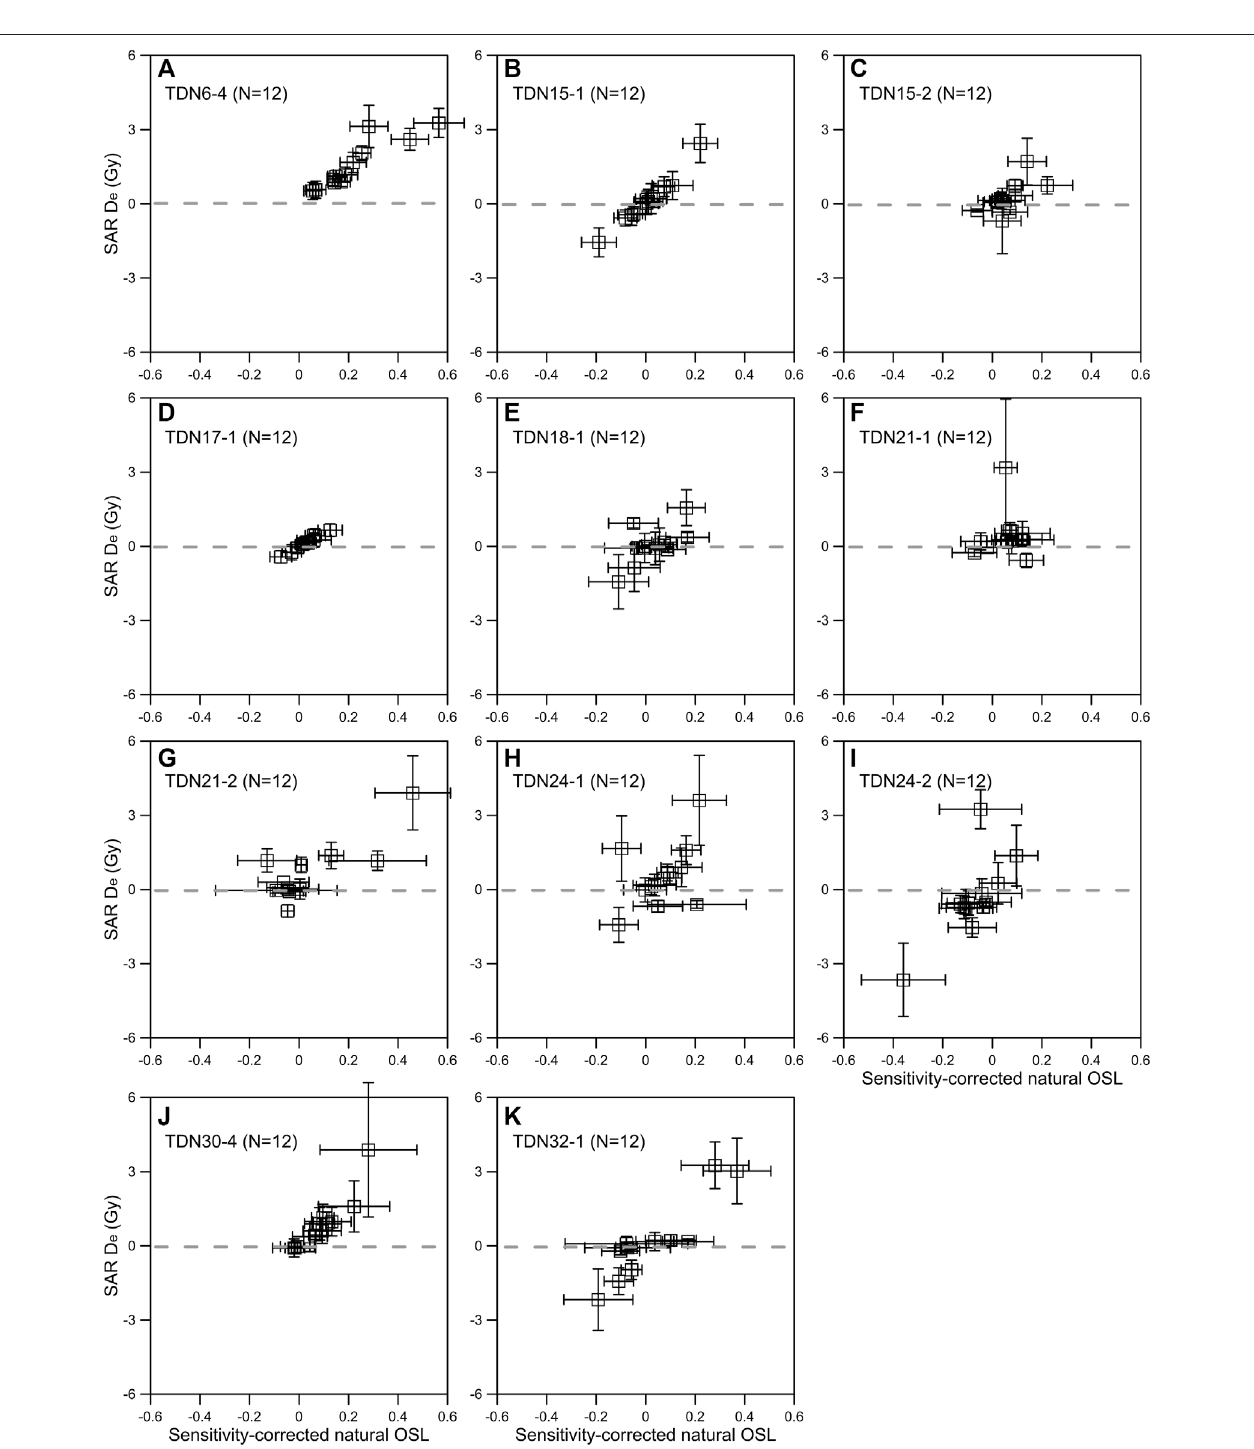
FIGURE 4 | Variations of SAR D e values as a function of the sensitivity-corrected natural OSL signals for different aeolian samples.